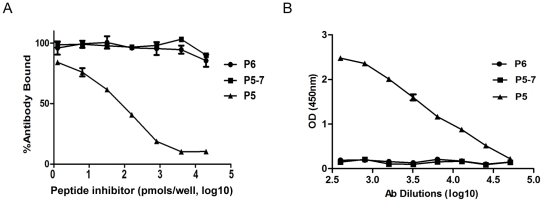
Peptide LRGVAPL fail to bind anti-P5 serum and inhibit P5-antibody interactions.(A) anti-P5 serum was tested by ELISA for its ability to bind to P5 peptide in the presence of dilutions of peptide P5–7 (LRGVAPL). P5 (LCKLRGVAPLHLGKC) and P6 (HLGKCNIAGWILGNP) were used as positive and negative controls, respectively. (B) The reactivities of anti-P5 sera (1∶400 dilution) with the peptides P6, P5–7, and P5 were analyzed by ELISA. The OD450nm values are expressed as mean ± SD.